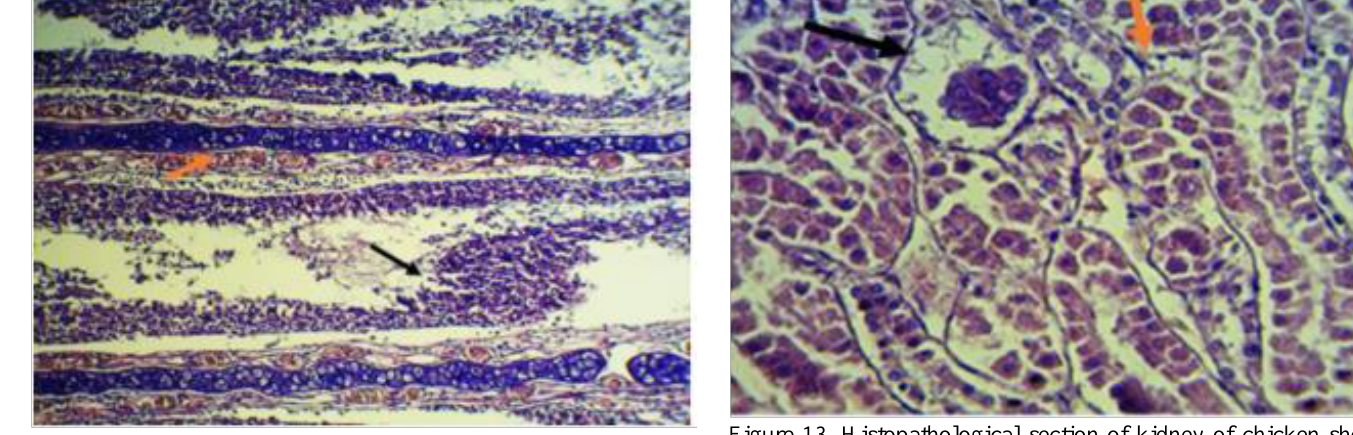
Figure 10. Histopathological section of gills shows extensive sloughing in gills filaments ( ) with inflammatory cells infiltration and blood congestion of vessels (